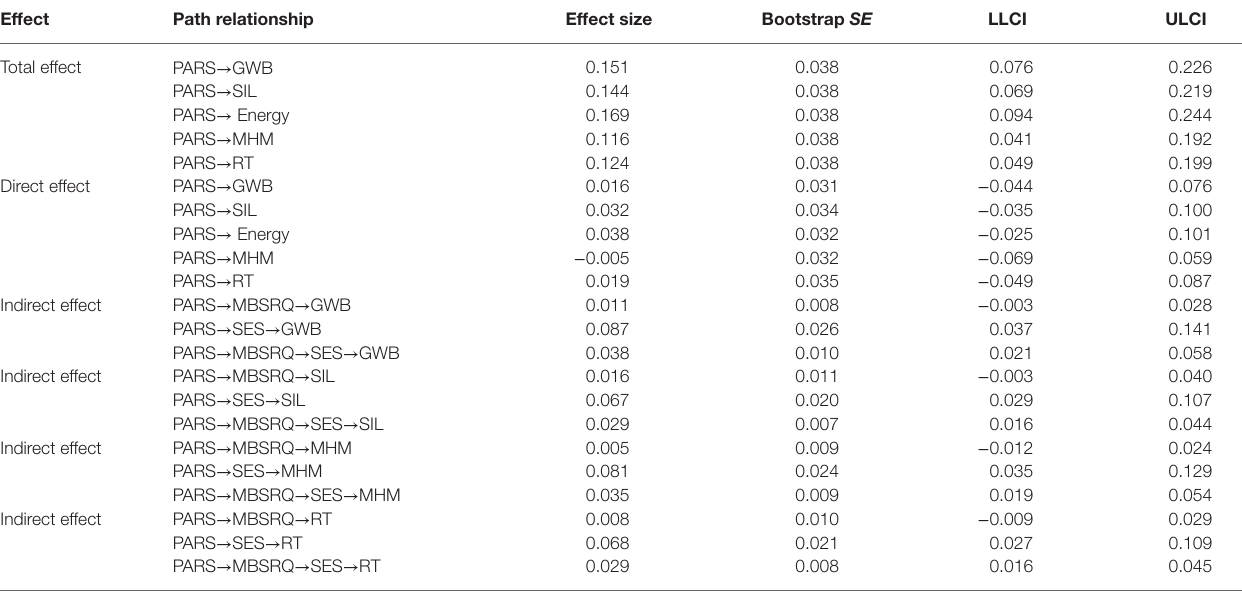
TABLE 5 | The path and effect decomposition table of physical exercise on subjective well-being. Effect Path